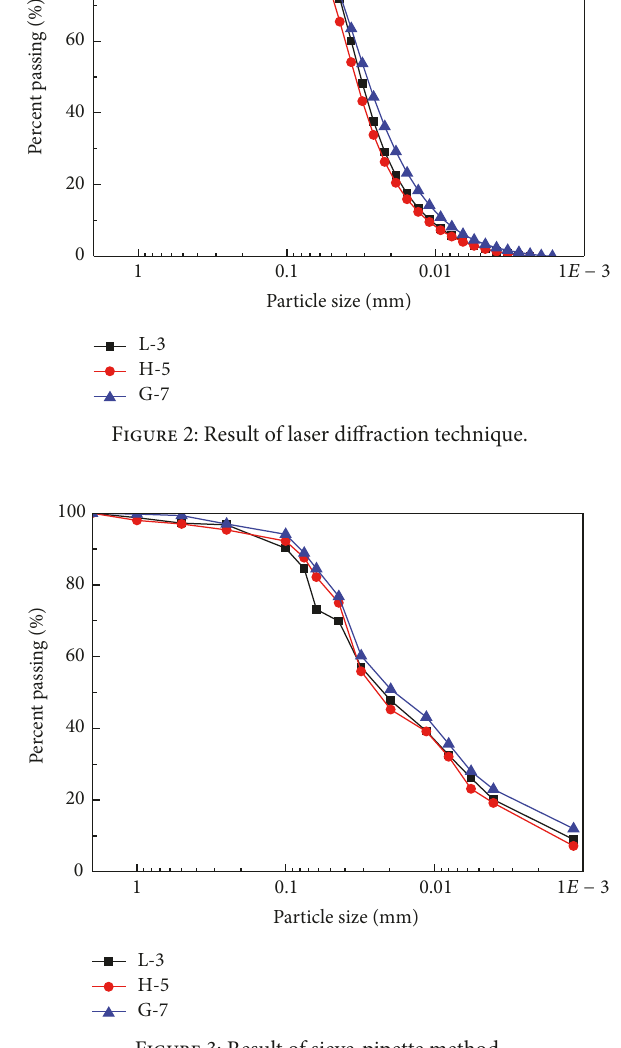
Figure 3: Result of sieve-pipette